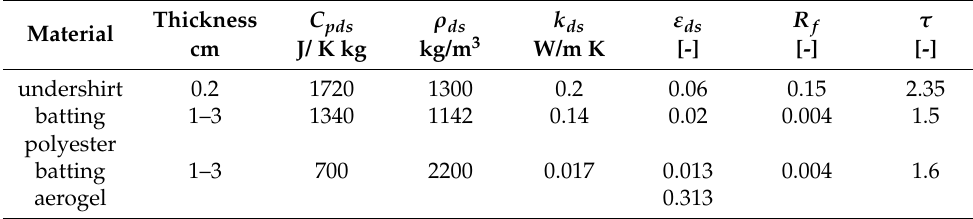
Table 3. Properties of materials used in simulations.